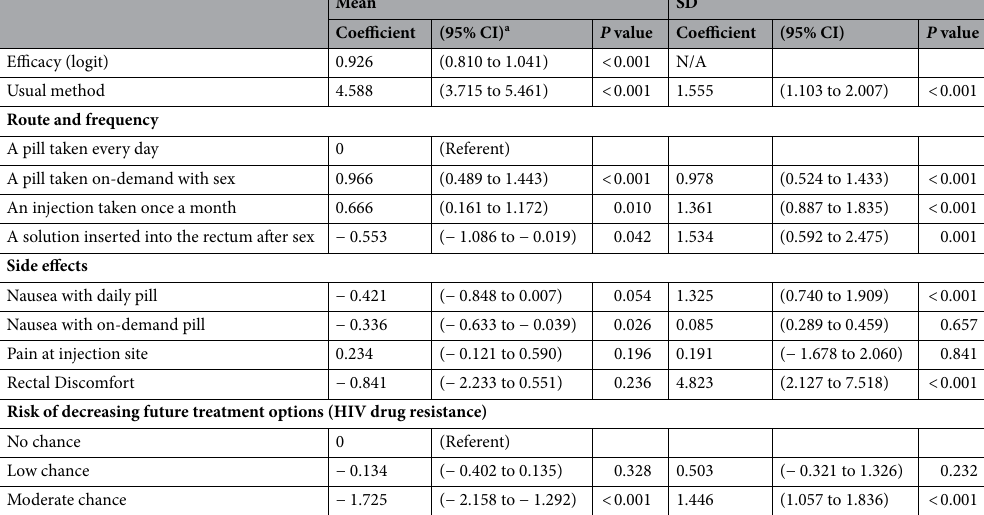
Table 2. Results of mixed multinomial logit model incorporating efficacy as the logit of efficacy. a CI denotes confidence